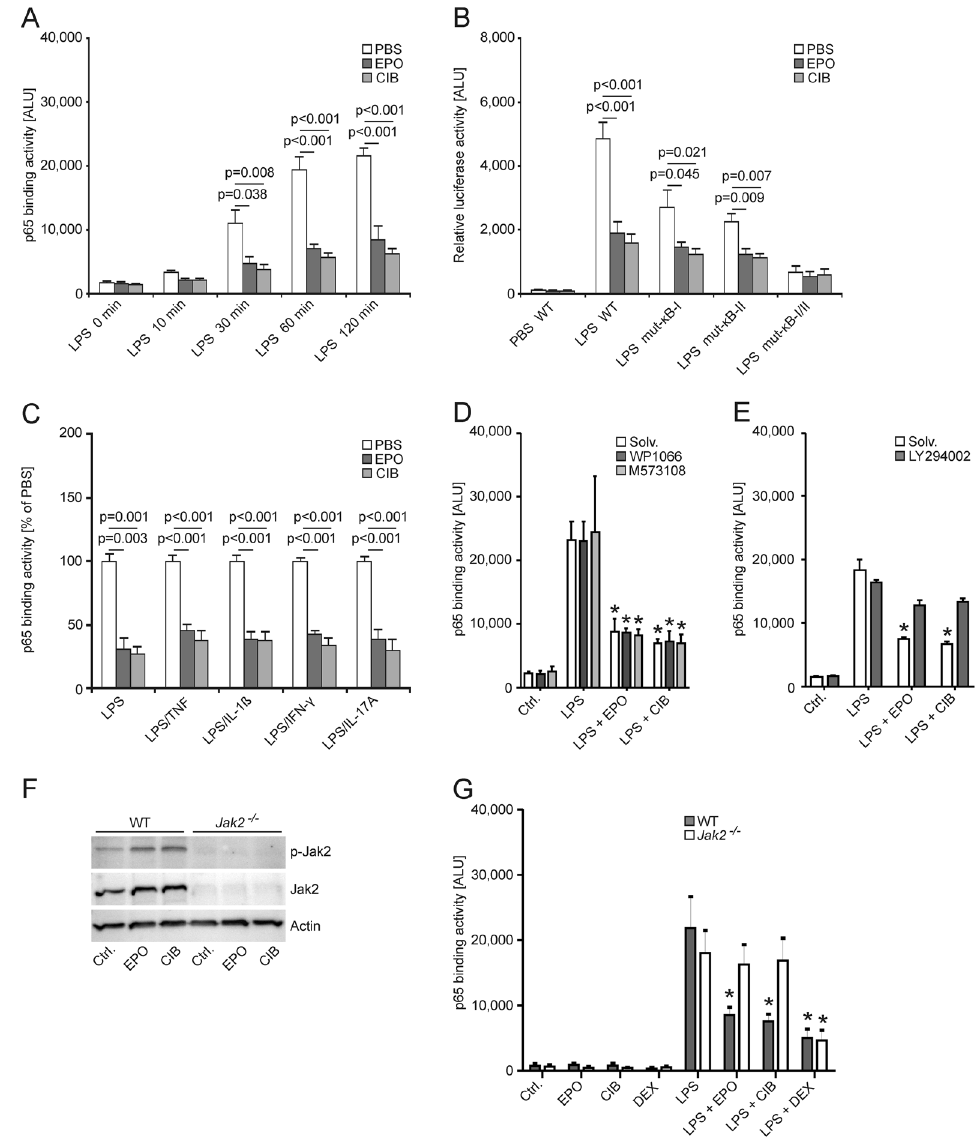
Figure 6. Cibinetide induces JAK2 phosphorylation and inhibits NF- κ B p65 activation in BMDMs in vitro . ( A ) BMDMs were treated with PBS, 2 pmol/mL EPO, 2 pmol/mL cibinetide (CIB) and 200 ng/mL LPS. NF- κ B p65 DNA binding activity in nuclear extracts was evaluated using a chemi-luminescent transcription factor assay at the indicated time points. Data of 3 independent experiments are expressed as arbitrary light units and shown as means ± S.E.M. and were compared using ANOVA. Statistically significant differences between LPS-stimulated cells pre-treated with either PBS, EPO or cibinetide are indicated. ( B ) BMDMs were transiently transfected with a full-length murine Nos2 promoter luciferase reporter or with constructs carrying site-specific mutations in one or both NF- κ B binding sites (mut- κ BI-Nos2-luc and mut- κ BII-Nos2-luc or mut- κ BI/II-Nos2-luc, respectively). Relative luciferase activity after pre-treatment with PBS, EPO or cibinetide and subsequent stimulation with LPS is shown. Data from 6 independent experiments were compared by ANOVA. ( C ) BMDMs were pre-treated as above and stimulated with LPS without and with co-stimulation with rmu TNF, IL-1ß, IFN- γ and IL-17A (10 ng/ml each). Nuclear NF- κ B p65 binding activity was quantified. Data of 4 independent experiments are expressed as relative (to PBS-treatment) arbitrary light units and shown as means ± S.E.M. and were compared by ANOVA. Statistically significant differences between LPS-stimulated cells pre-treated with either PBS, EPO or cibinetide are indicated. ( D , E ) Following the addition of solvent, 10 µ M WP1066, 200 µ M M573108 or 50 µ M LY294002, BMDMs were treated with PBS, EPO, cibinetide and LPS. Nuclear NF- κ B p65 binding activity was measured. Data of 3 independent experiments are expressed as arbitrary light units and shown as means ± S.E.M. and were compared by means of ANOVA. * p < 0.001 as compared to the addition of LPS/solvent. ( F ) BMDMs were isolated from Jak2 − / − mice and Jak2 - + / + littermates. Cells were stimulated with PBS, EPO or cibinetide to verify the presence or absence of Jak2, respectively. ( G ) In independent experiments, BMDMs were stimulated with PBS, EPO, cibinetide (CIB) or 50 µ g/ml dexamethasone (DEX). NF- κ B p65 binding activity was quantified. * p < 0.05 as compared to LPS/solvent stimulation in the respective genotype